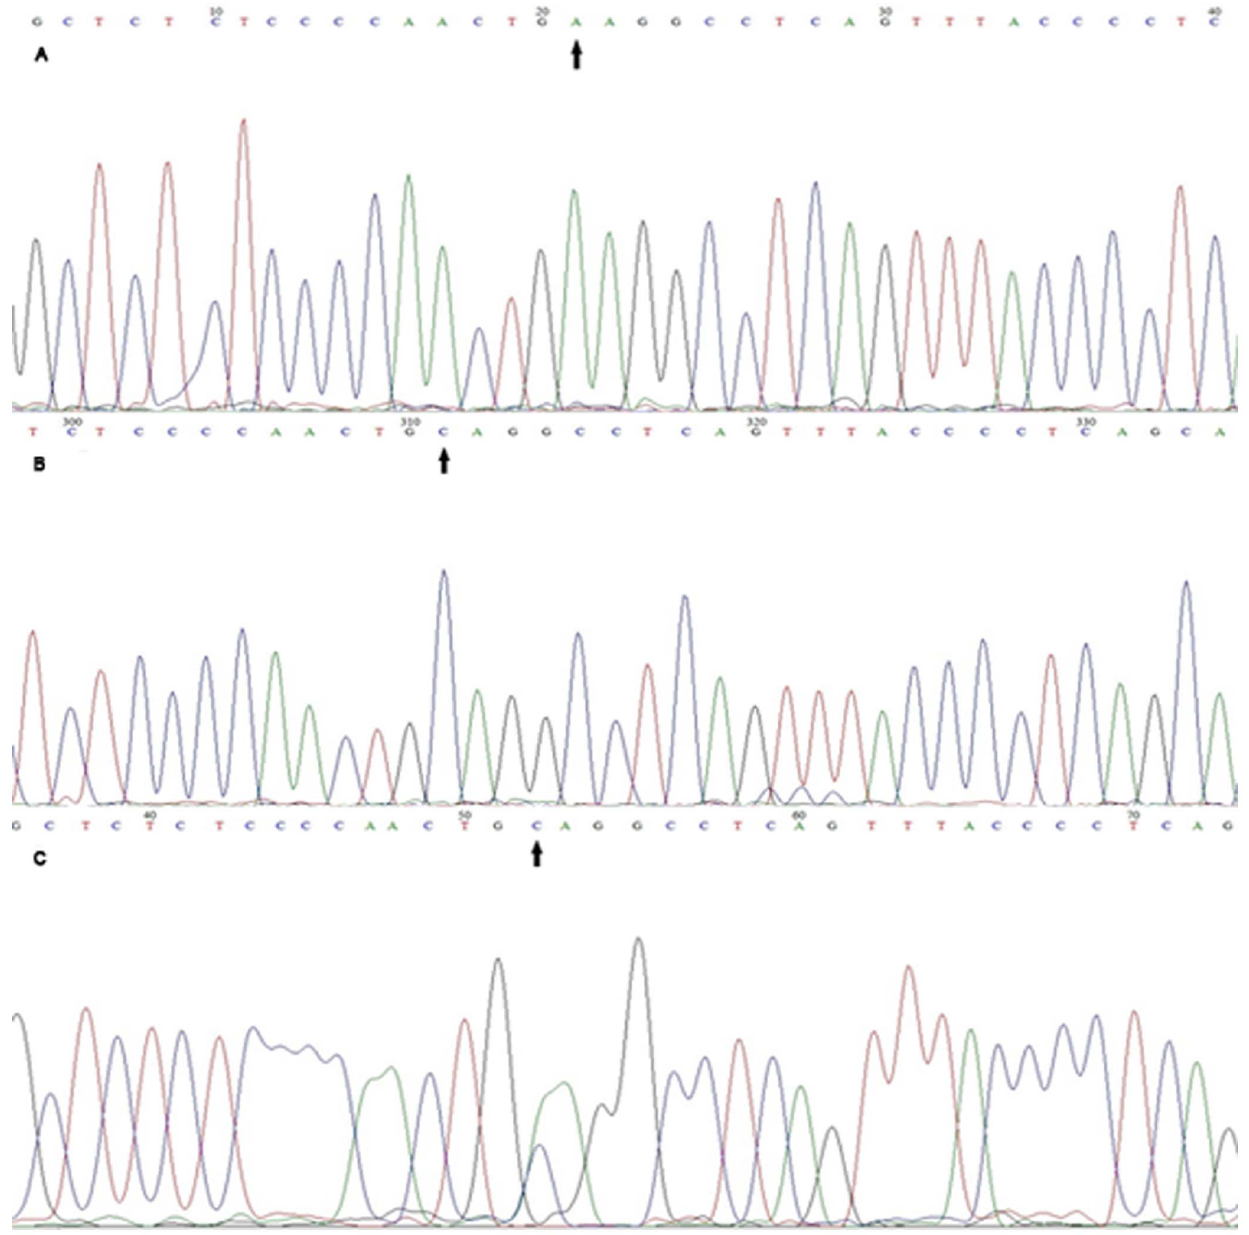
Figure 3. Sequencing results of Foxp3 -3279. Figure 3A was the sequencing of Foxp3 -3279A/A genotype; Figure 3B was the sequencing of Foxp3 - 3279C/C genotype. Figure 3C was the sequencing of Foxp3 -3279 A/C genotype. The arrow part was the SNP